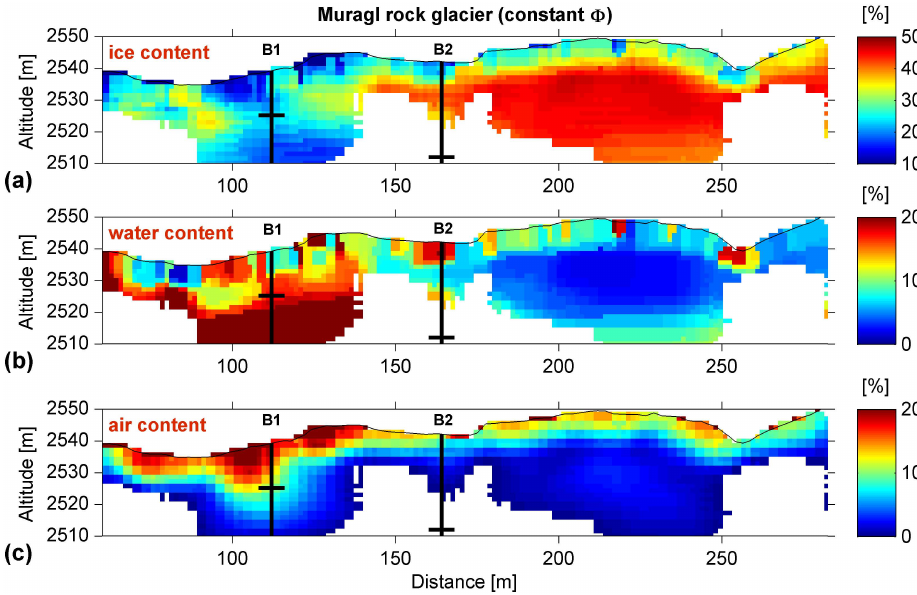
Fig. 7. 4-phase model results for Muragl rock glacier calculated with a constant porosity model of 50%. The locations of the two boreholes are indicated by black vertical lines – the depth of the water table by the black horizontal lines. (a) Ice content, (b) water content and (c) air